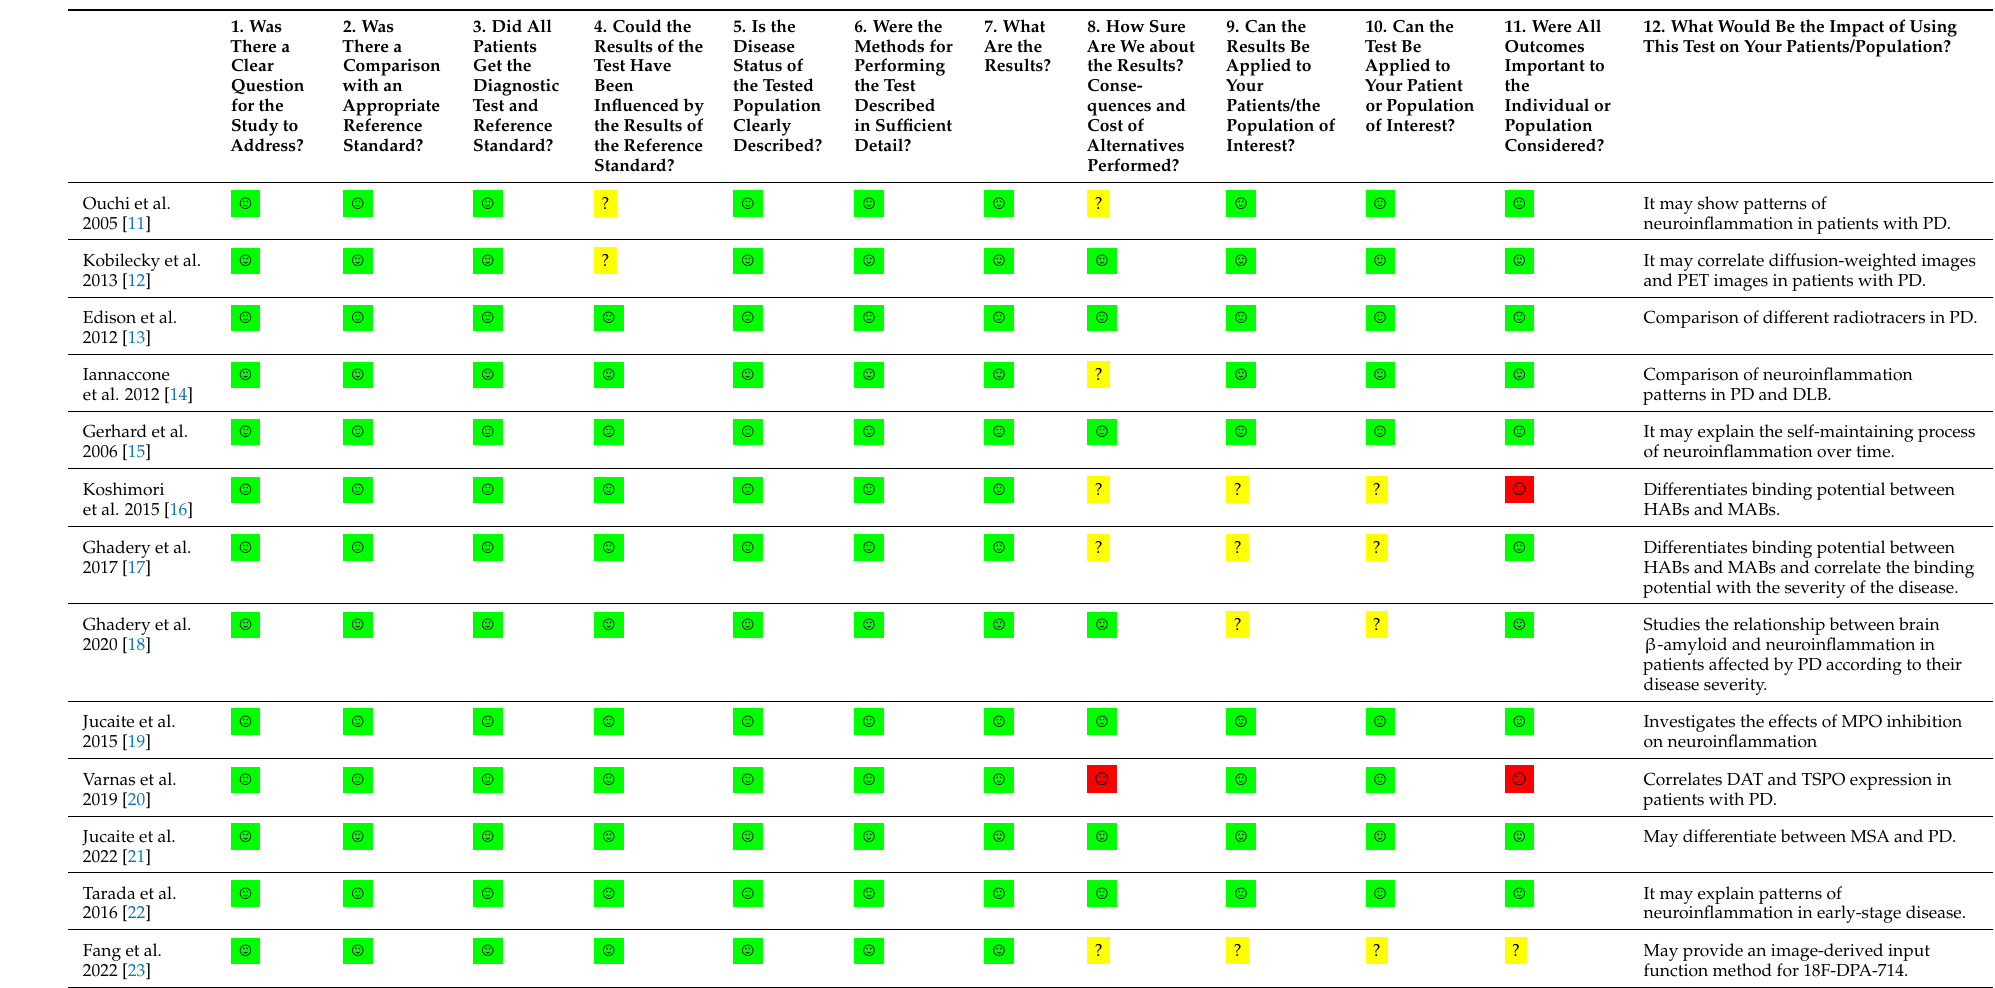
Table 2. Quality